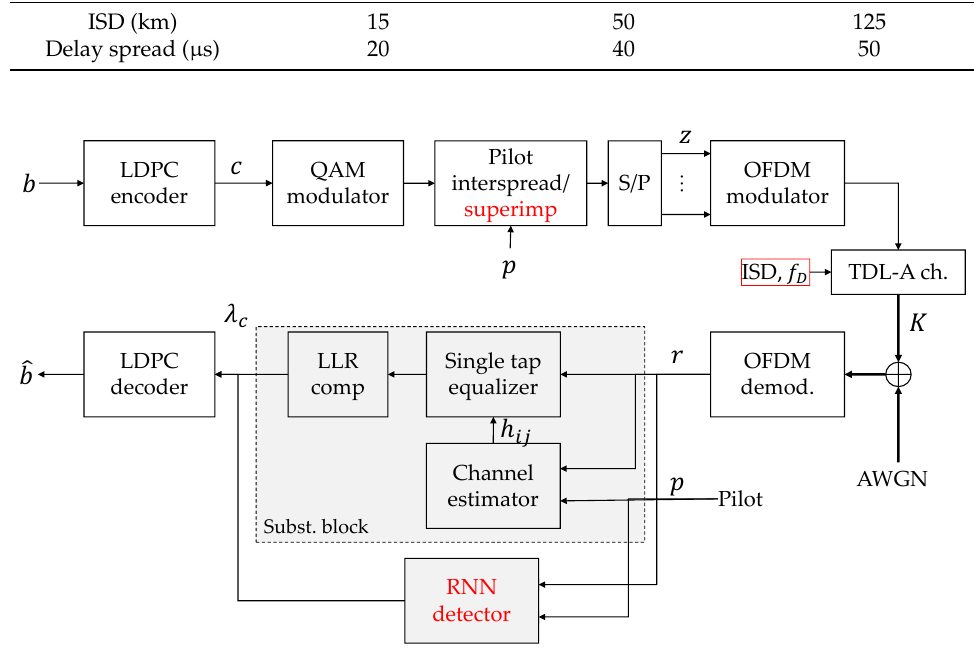
Figure 1. The OFDM system and position of the proposed RNN